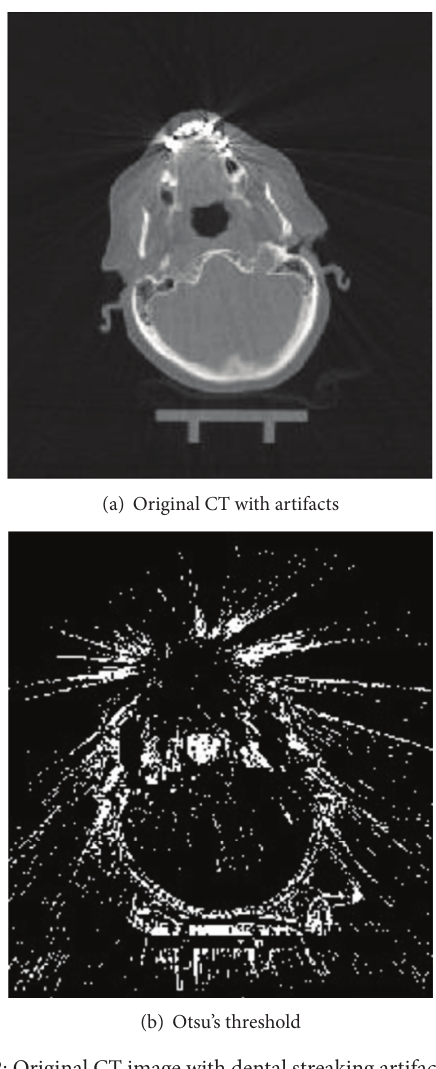
Figure 2: Original CT image with dental streaking artifacts (a) and detected artifacts with Otsu’s thresholding method